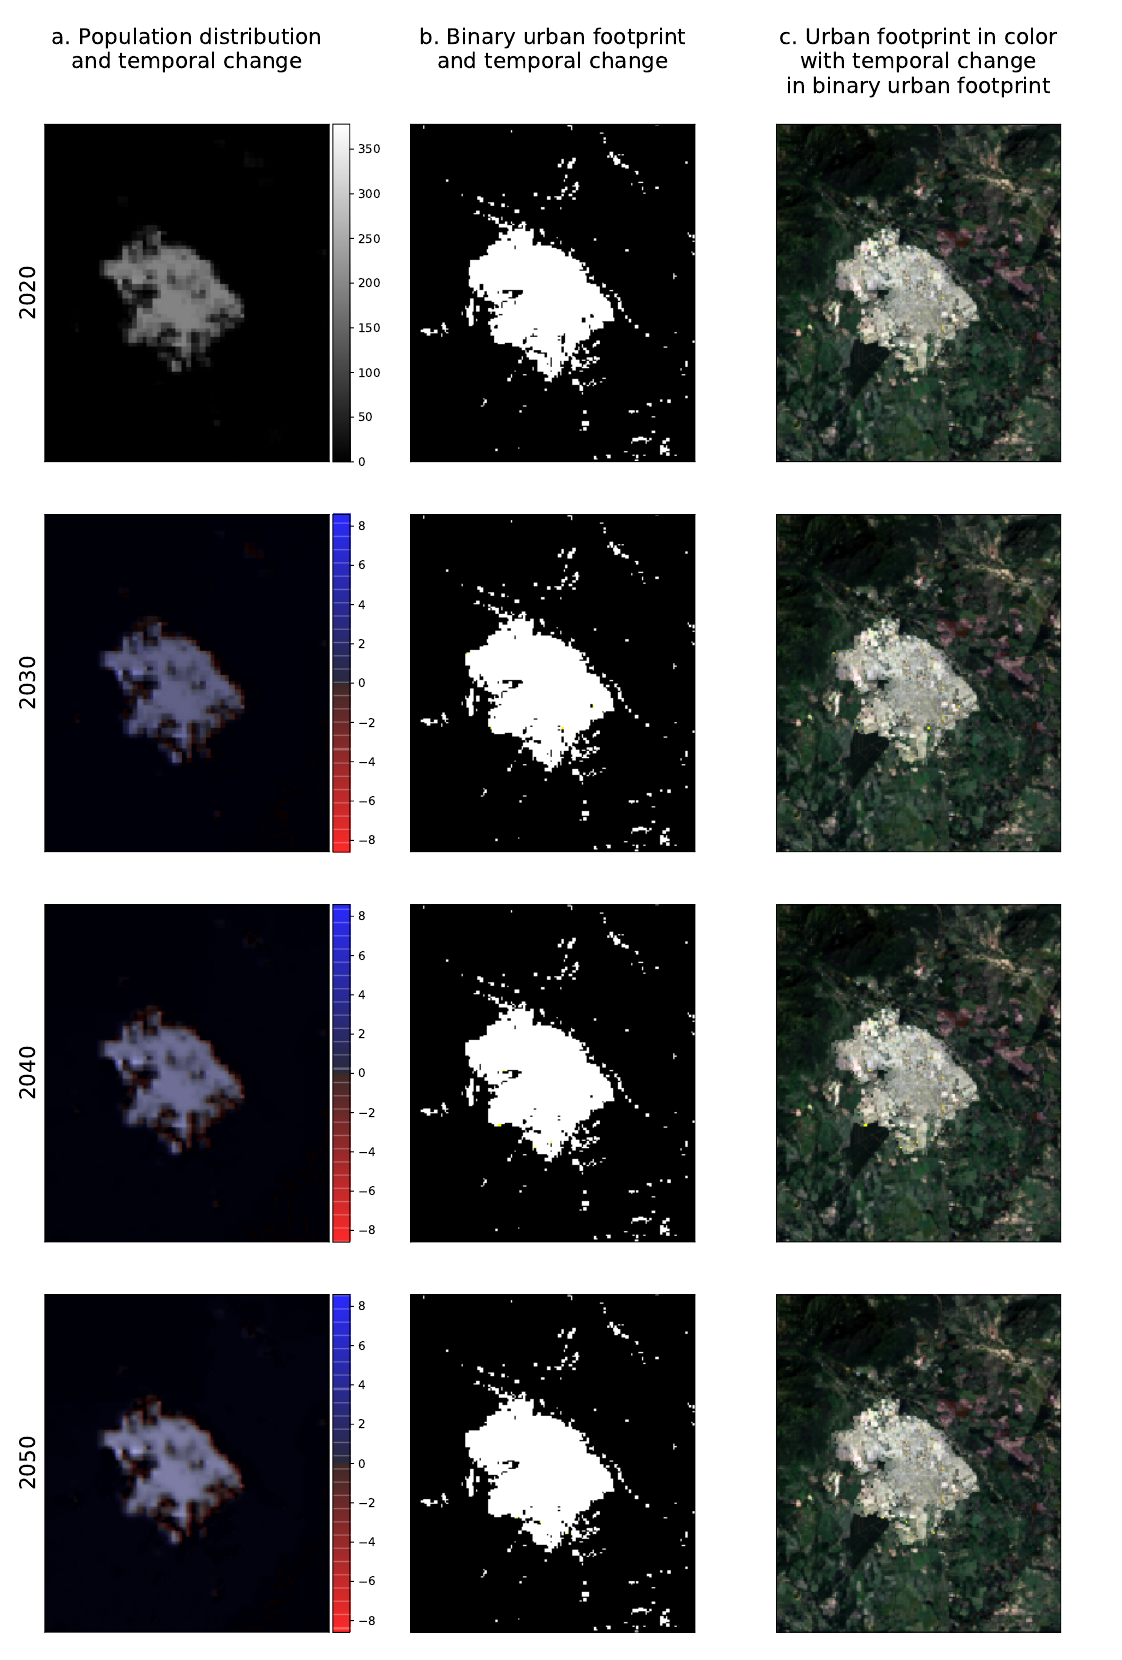
Figure 26. Urban growth predictions in the geographic area of interest that includes